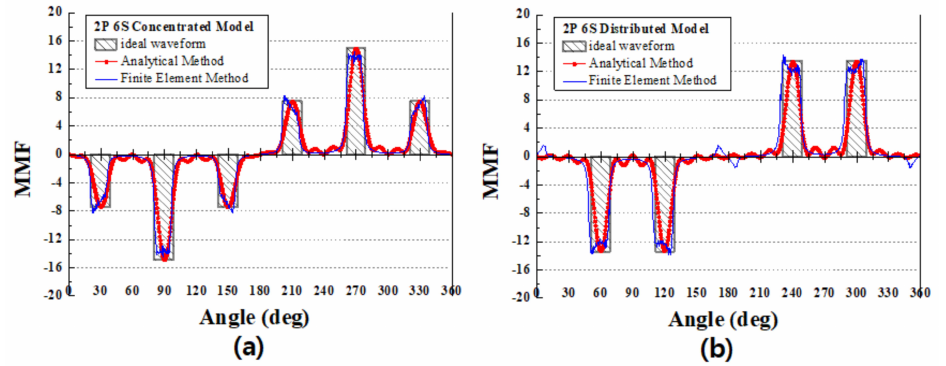
Figure 4. Comparison of MMF waveforms according to analysis methods of ( a ) concentrated model and ( b ) distributed model.